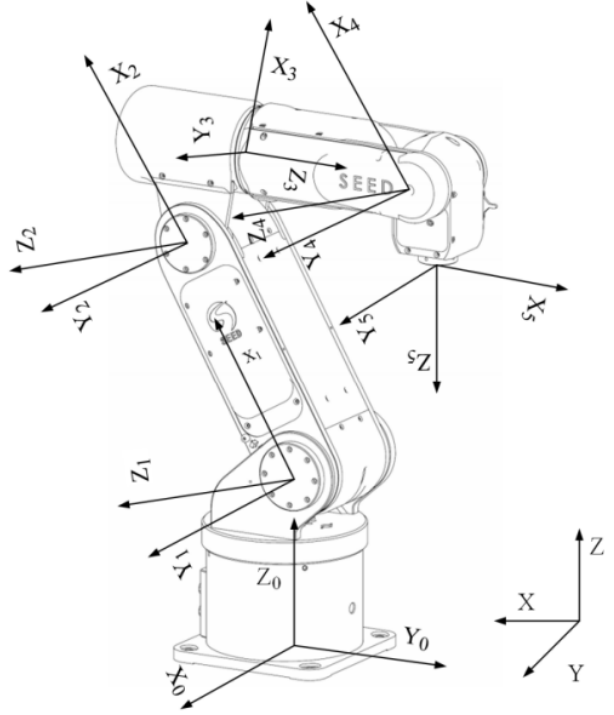
Figure 4. Reference frame representation used in kinematic calculations of the robotic arm.